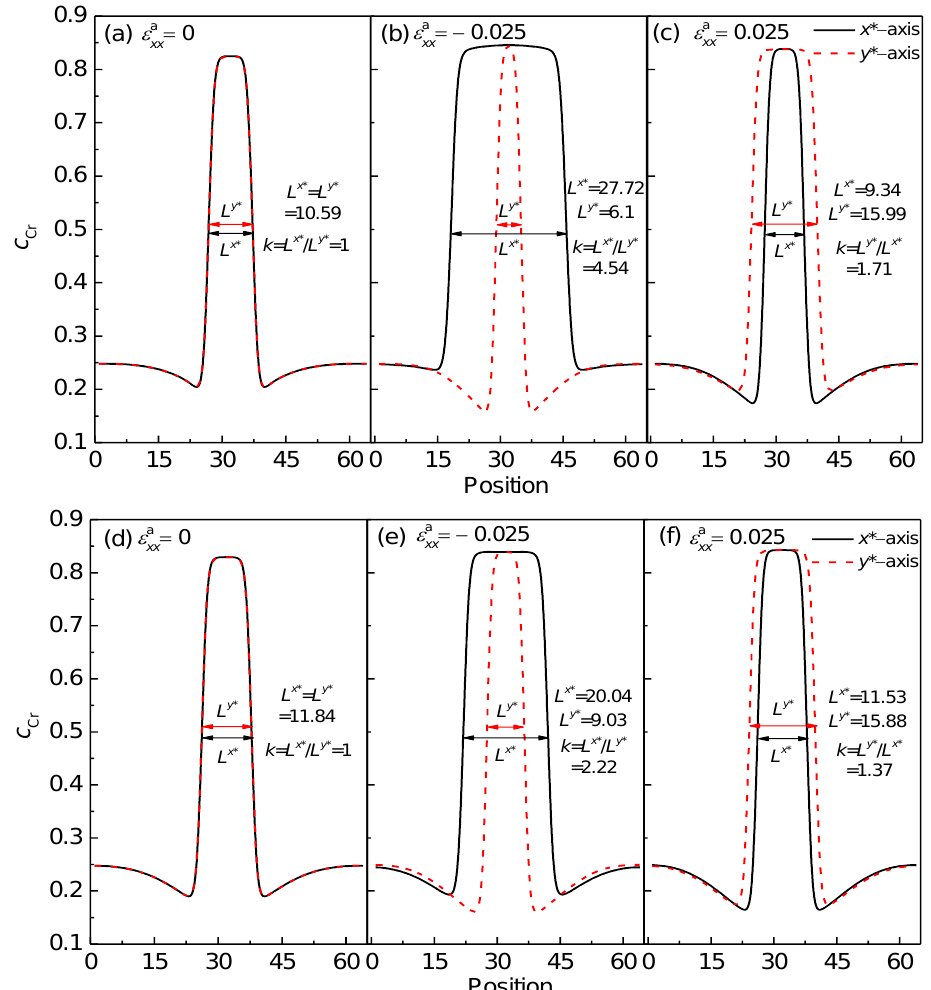
Figure 2. The concentration distributions of Cr in the α′ phase along x * = 32 and y * = 32 with and without normal strain at 750 K for t* = 50. ( a – c ) c i